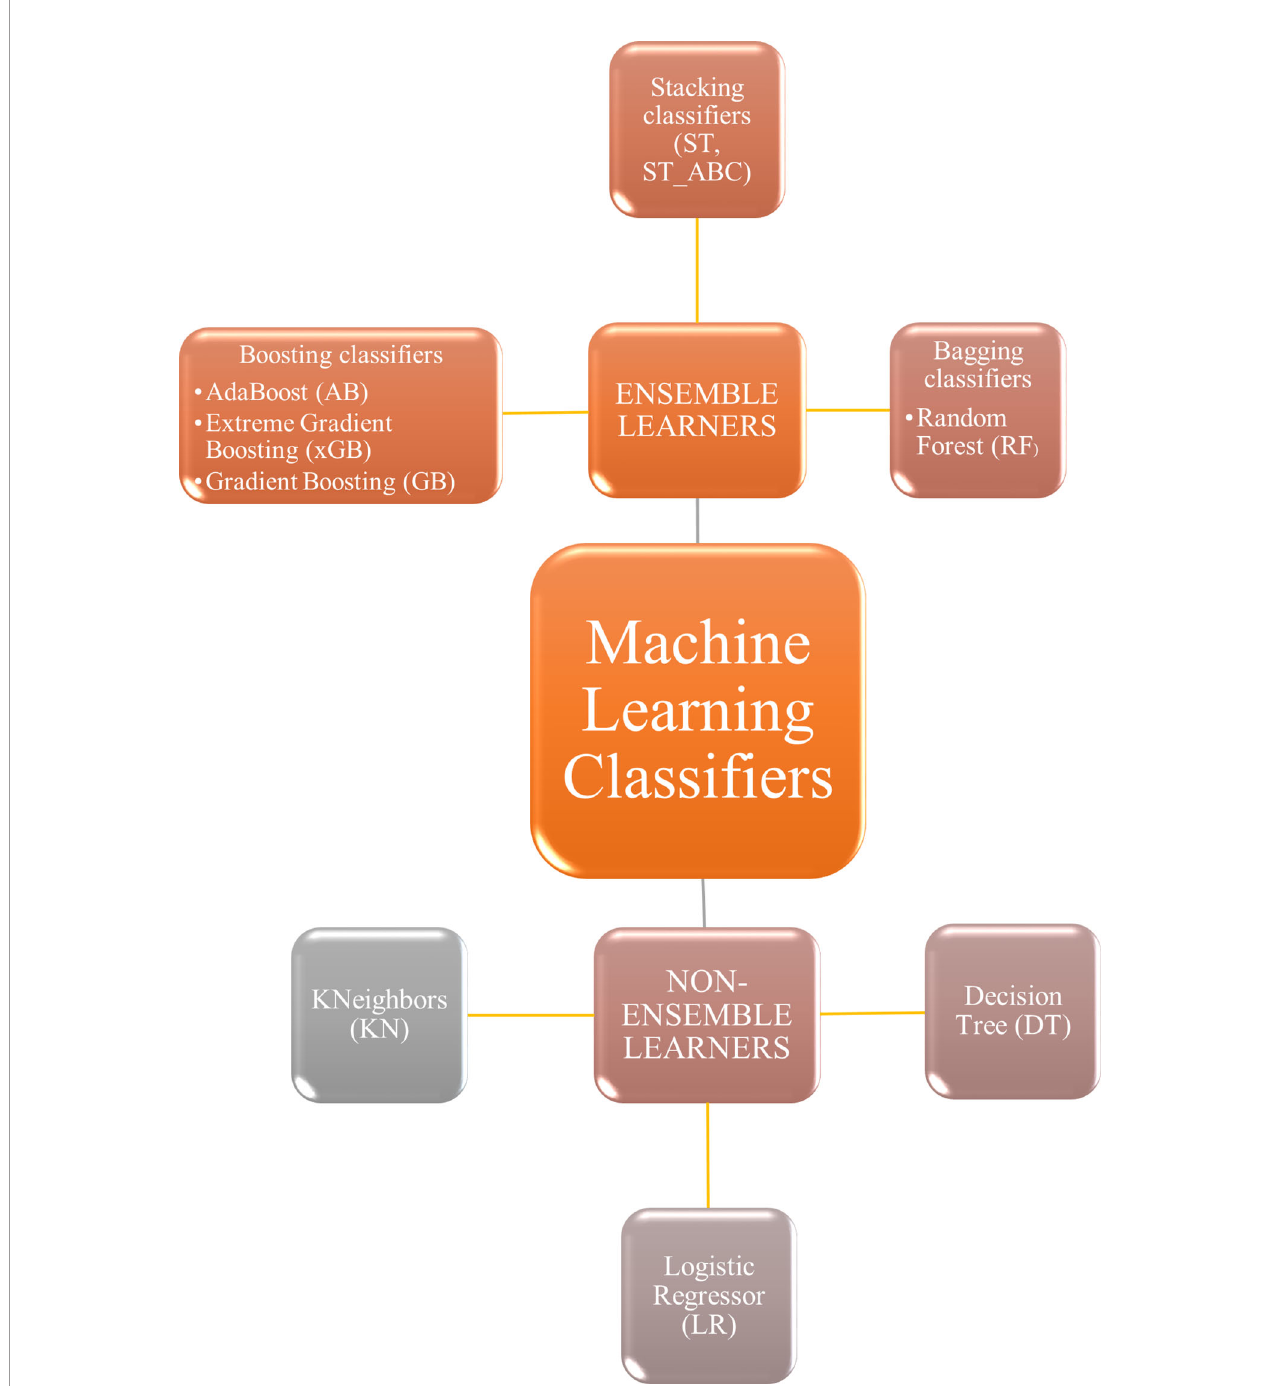
FIGURE 2 | Machine learning classi fi ers tested in the present study. Non-ensemble learners included KNeighbors, logistic regressor, and decision tree. Ensemble learners included boosting, stacking, and bagging classi fi